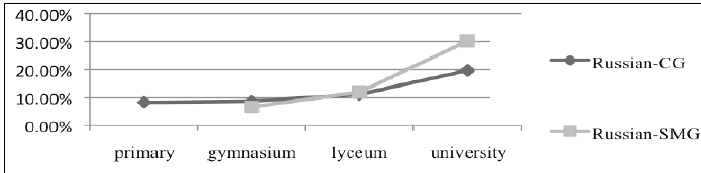
Figure 7: Level of education of the participants and non-target test